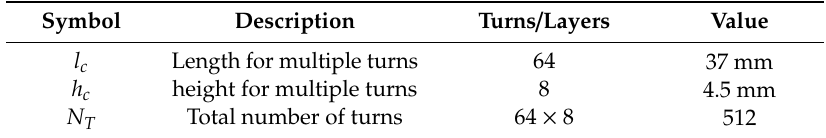
Table 1. Selected parameters for coil configuration, (copper wire (AWG23, 0.57mm diameter)).